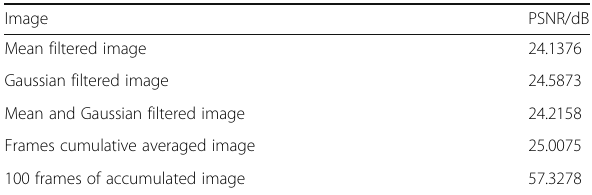
Table 3 The PSNRs of frame accumulated image and its mean image and the single-channel image processed by the conventional filtering method Image